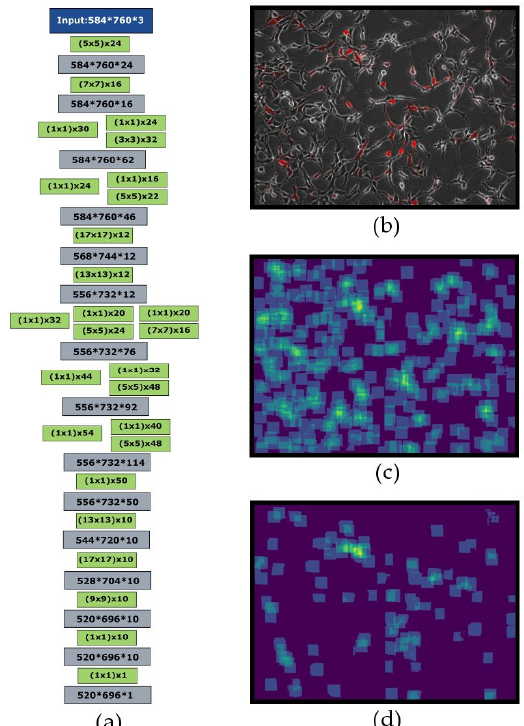
Figure 1. CellCountCV FCNN model architecture and microimage examples. The architecture of the developed FCNN model. Green blocks correspond to convolutional layers, where filter sizes are shown in brackets and additional numbers are the numbers of filters. ( a ) Numbers in grey blocks are output layer sizes. Batch-norm blocks are put after each convolutional or inception block and not shown; ( b ) Examples of original image section; ( c ) Corresponding count map; ( d ) The count map of the cells with red fluorescence above the selected threshold.